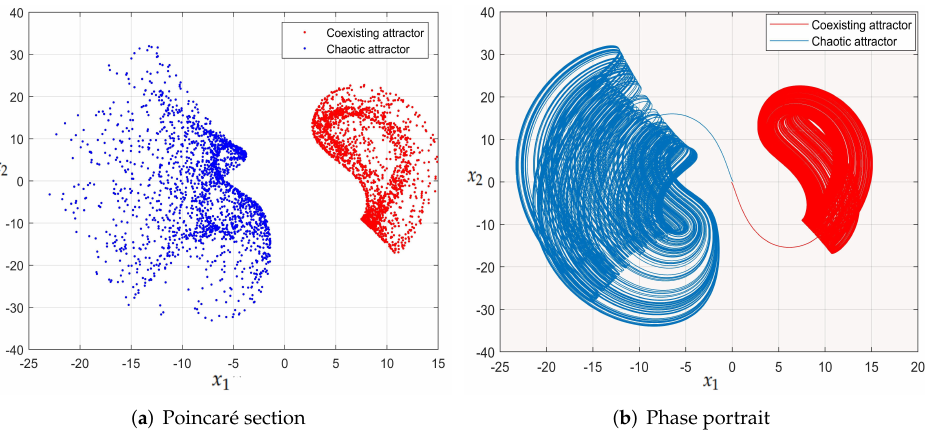
Figure 10. Poincaré section and corresponding phase portrait of chaotic attractor vs. coexisting attractor in system (2) for x 1 − x 2 plane.